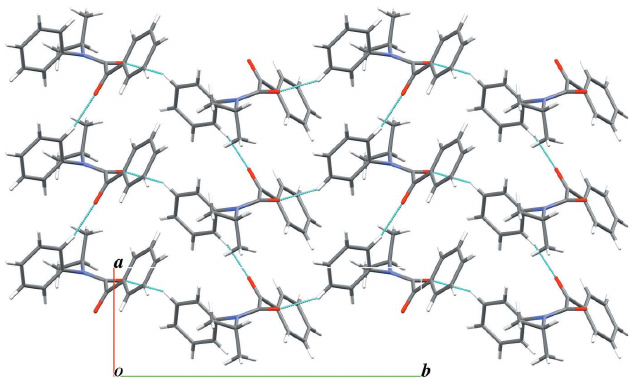
Figure 3 A packing diagram viewed along the c axis isfor the title compound 1c , showing C—H (cid:2)(cid:2)(cid:2) O interactions as dotted blue